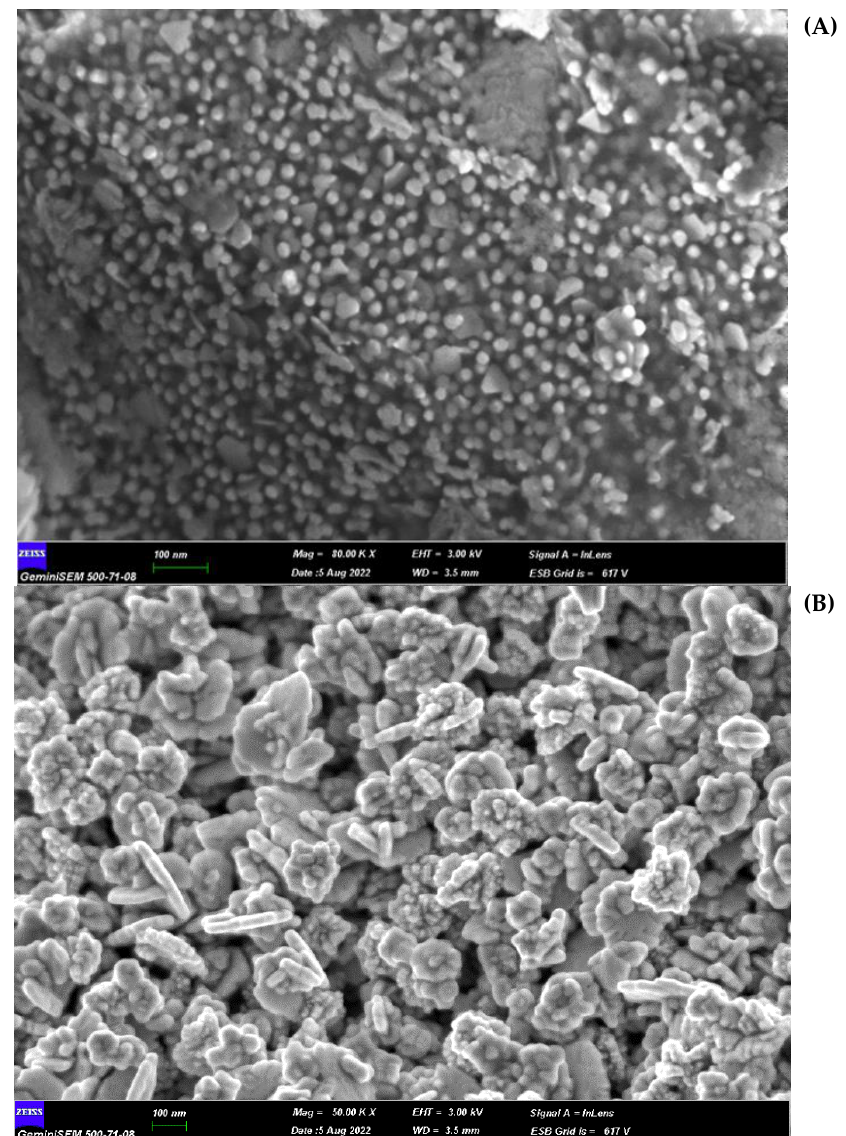
Figure 2. FE-SEM image showing the surface morphology of green synthesized AuNFs. AuNFs represent gold nanoflowers; H-AuNFs from Helichrysum italicum extract ( A ); and R-AuNFs from Rosmarinus officinalis extract ( B ).